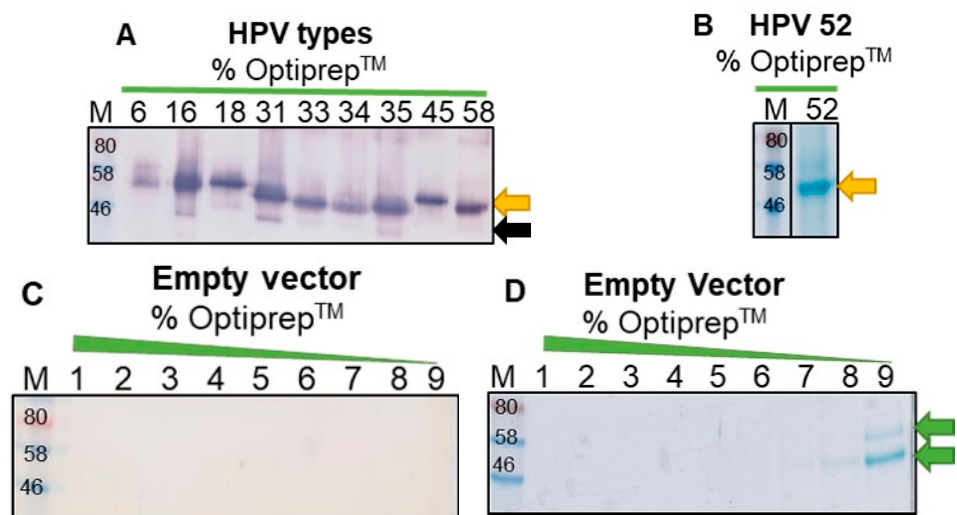
Figure 1. Analysis of plant produced HPV VLPs: ( A ) western blot of all HPV types detected with anti-Gardasil ® ; ( B ) Coomassie-stained gel for HPV 52; ( C,D ) western blot and Coomassie-stained gel for the empty vector, respectively. Purified HPV L1 proteins (~56 kDa) were probed with rabbit-raised anti-Gardasil ® sera (1:2000 dilution) and anti-rabbit IgG alkaline phosphatase-conjugated secondary antibody (1:5000). Labels: M: pre-stained protein standard (kDa); yellow arrows: HPV L1 protein (~56 kDa); green arrows: native plant proteins; black arrow: HPV L1 cleavage product.